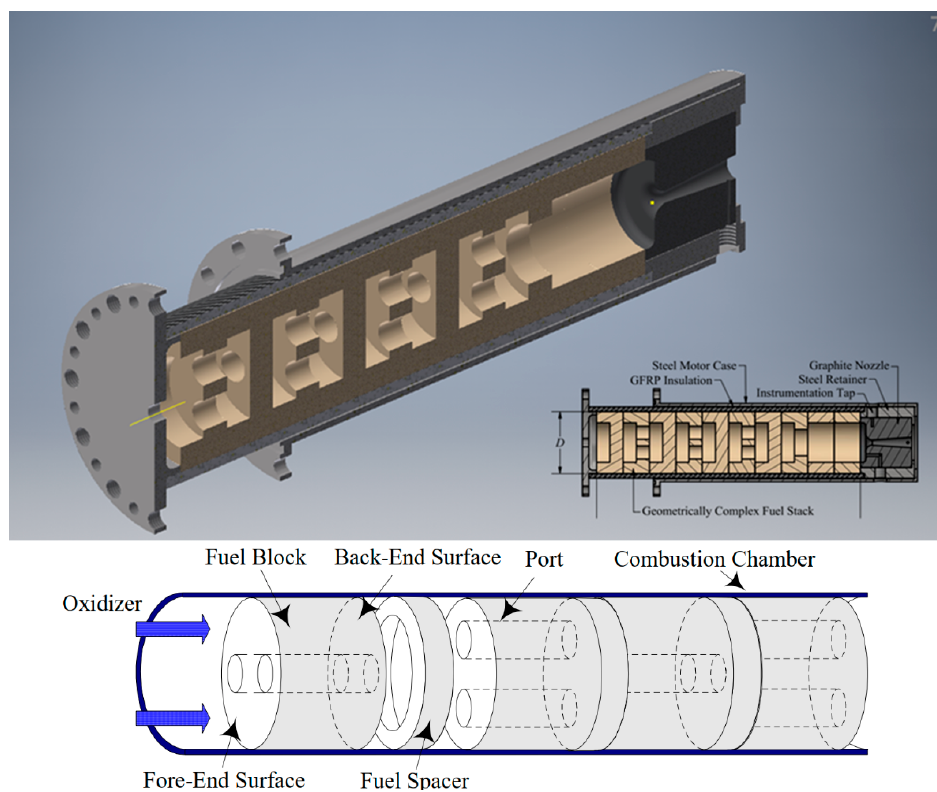
Figure 1. CAMUI fuel geometry concept ( top ) and burn surfaces ( bottom ).